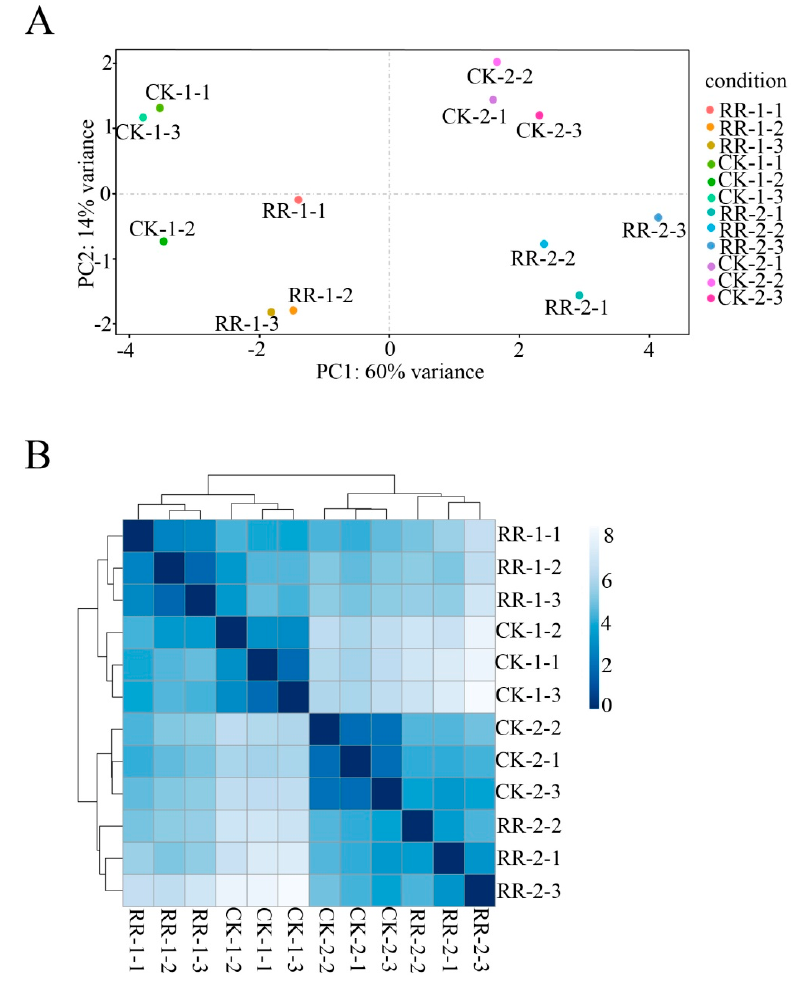
Figure 3. Principal component analysis ( A ) and sample to sample cluster analysis ( B ). RR-1-1, RR-1-2, and RR-1-3: Three replicas of fruit collected on 14 July 2017 under root restriction cultivation CK-1-1, CK-1-2, and CK-1-3: Three replicas of fruit in control group collected on 14 July 2017. RR-2-1, RR-2-2, and RR-2-3: Three replicas of fruit collected on 9 August 2017 under root restriction cultivation. CK-2-1, CK-2-2, and CK-2-3: Three replicas of fruit in control group collected on 9 August